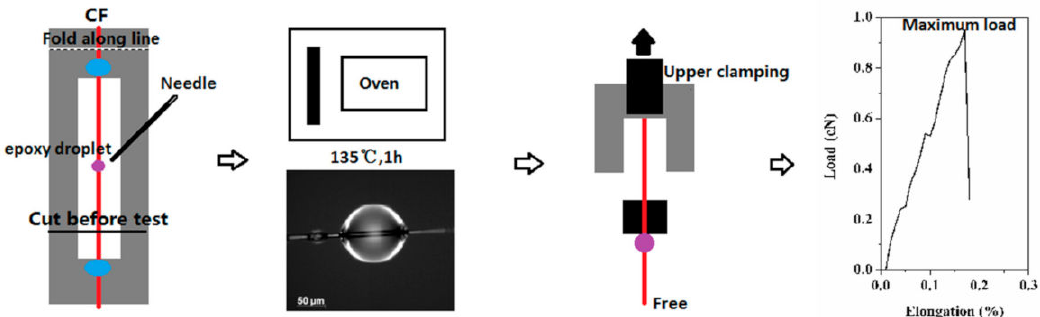
Figure 4. Schematic illustration of IFSS testing process: sample preparation, testing procedure and load–elongation